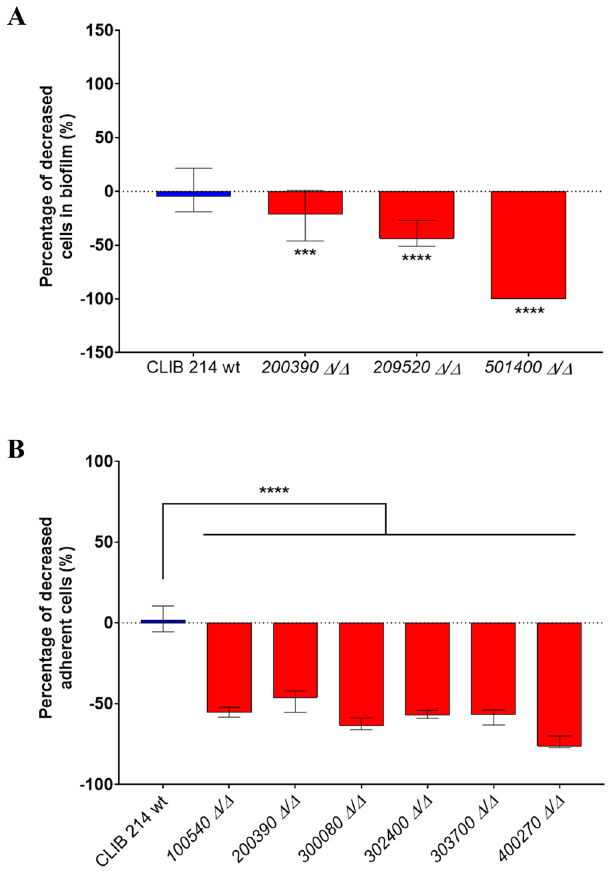
Figure 3. Biofilm formation and substrate adherence of the C. parapsilosis mutant strains. ( A ) - Biofilm formation in microtiter plates was determined using FDA assay. For mutants N ≥ 16 and for CLIB wt N = 196, from at least 2 independent experiments per strain were used. Obtained data were analyzed by Kruskal-Wallis and Dunn’s multiple comparisons tests ( *** p ≤ 0.001; **** p ≤ 0.0001). (B) - Adherence to polystyrene plastic as a substrate in microtiter plates was also measured. For adherence assays N ≥ 12 for all mutant strains and N = 36 for the wild type strain were used from at least 2 independent experiments per strain and analyzed by Kruskal-Wallis and Dunn’s multiple comparisons test ( **** p ≤